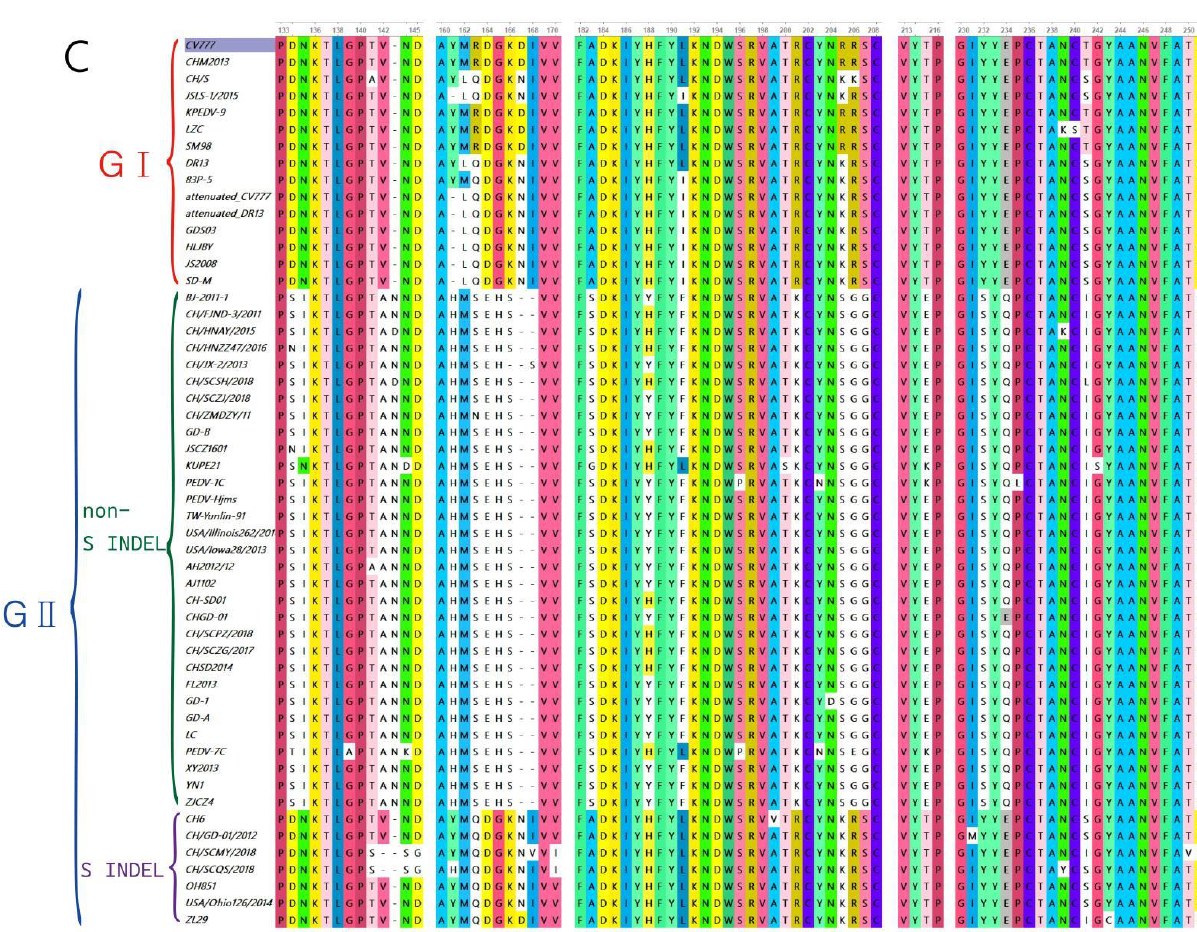
Figure 2. ( A ) The amino acid sequence differences of S proteins of different PEDV strains are shown, with the differences mainly concentrated in the N-terminal of S protein. ( B , C ) Amino acid sequences of the highly variable N-terminal region of the S proteins of various PEDV strains are shown in detail; the different genetic subgroups are indicated by brackets of different colors. The G2 non-S INDEL PEDV strain has a different genetic profile than CV777, while the G2 S INDEL PEDV strain has a higher similarity to CV777.